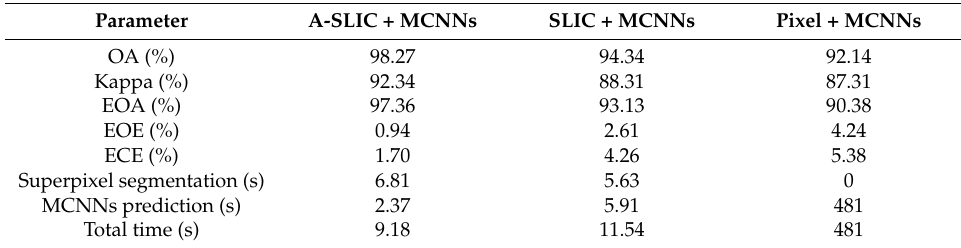
Table 2. Statistics of different superpixel